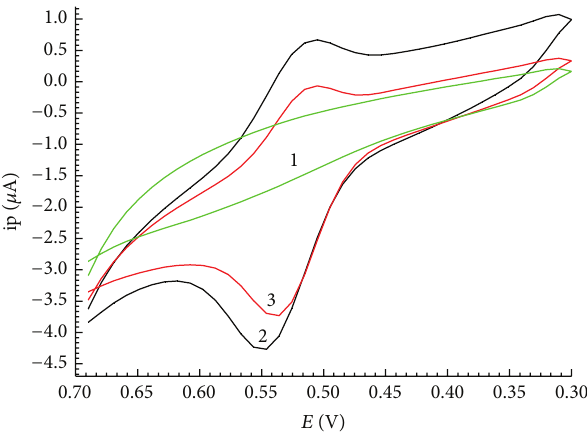
Figure 2: Cyclic voltammograms of ARS and ARS-PTH. Condition: 1.3.0 mLpH5.0PBS;2.1+1.0 × 10 −5 mol/LARS;3.2+30 mg/LPTH.